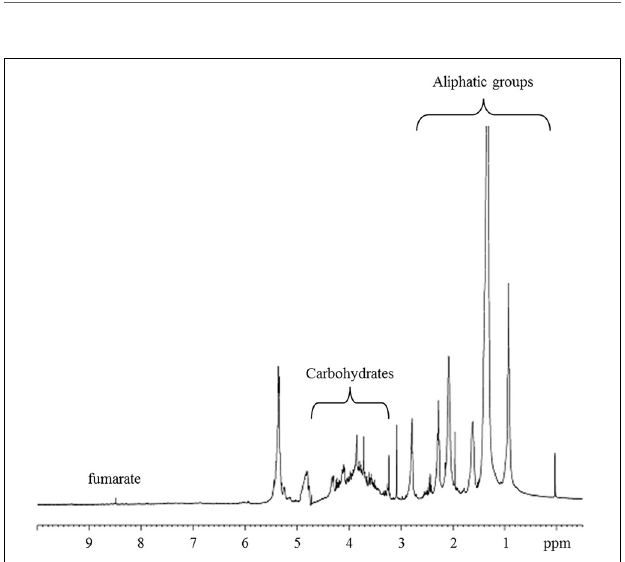
FIGURE 5 | 1 H-HRMAS-NMR spectrum of red fruits treated with alfalfa hydrolyzed (AH).